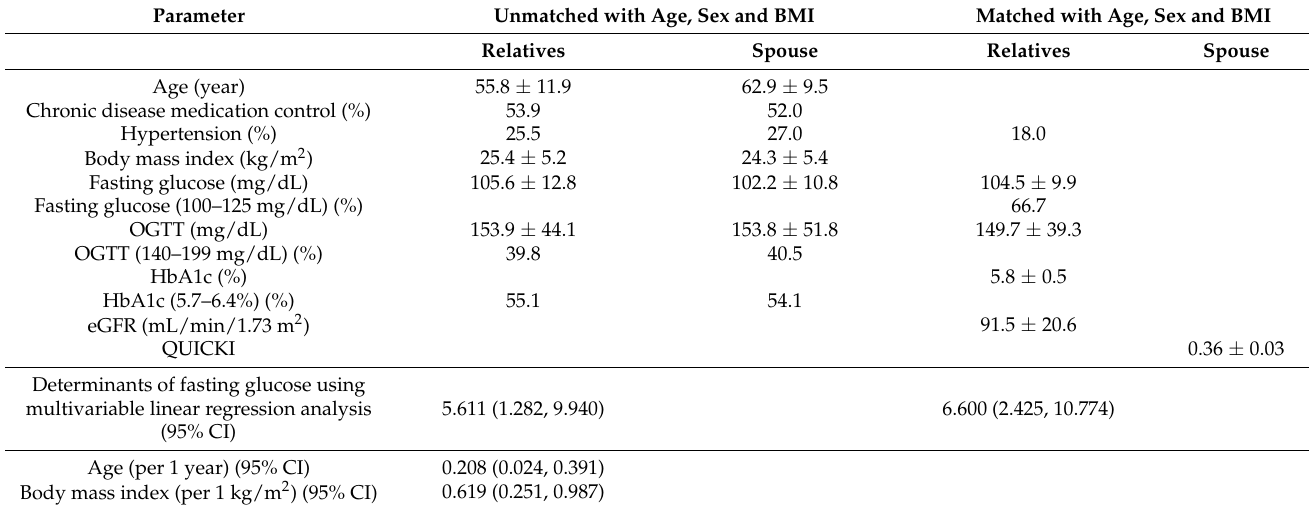
Table 10. Description summarizing all the significant findings of the study (Control group as